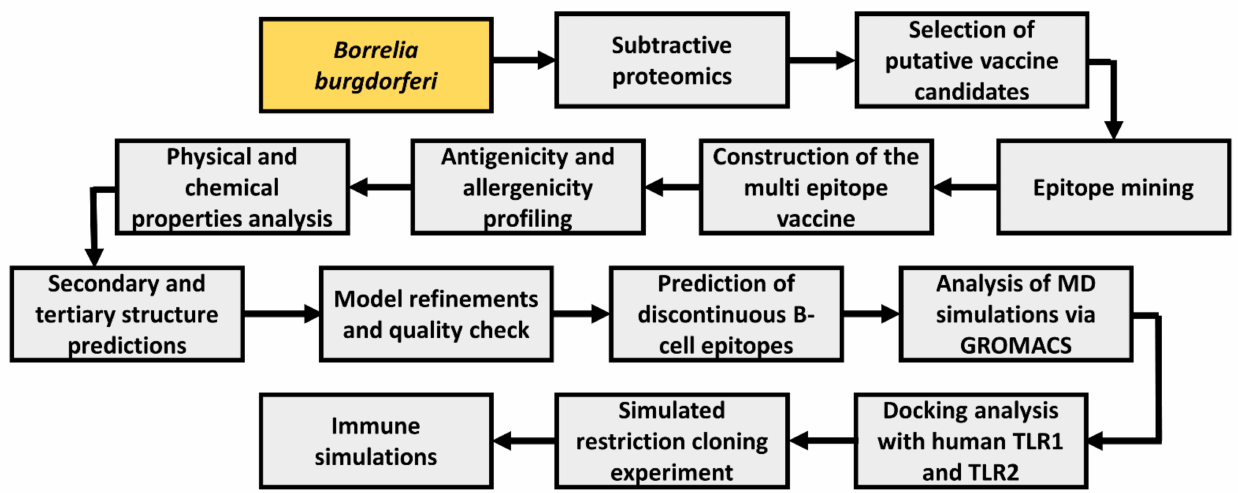
Figure 1. Workflow blueprint employed throughout the study. Study bacteria is depicted in yellow boxes, while study procedures are depicted in gray